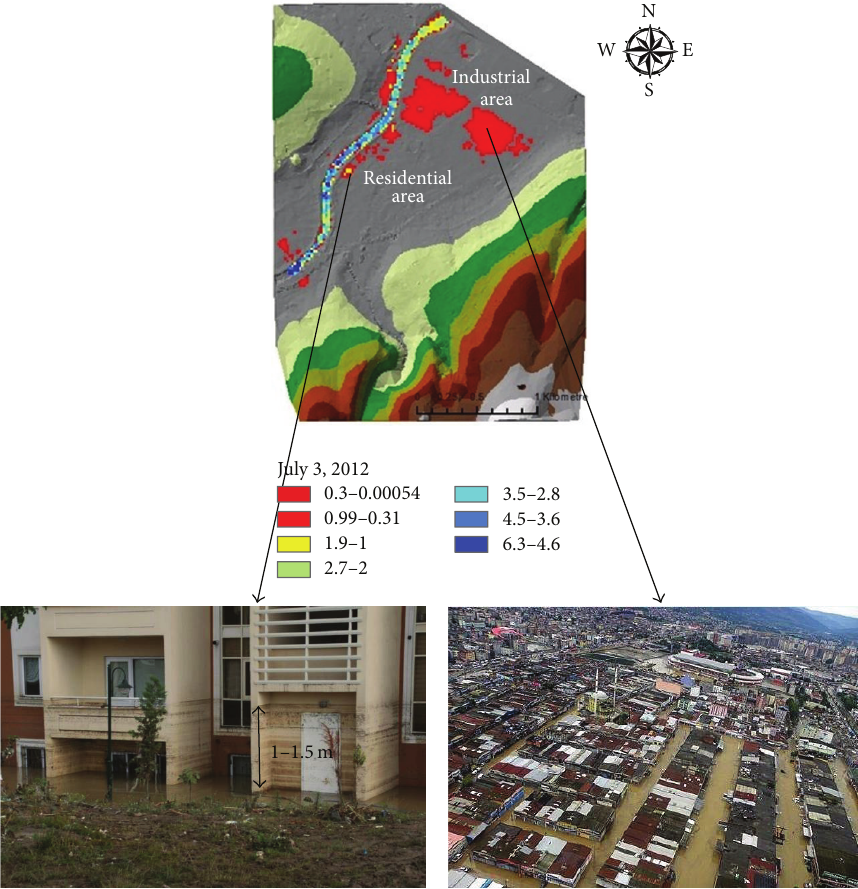
Figure 6: Flood hazard map and a photograph indicating the flood instants in industrial and residential area for the flood of July 3, 2012 [1,